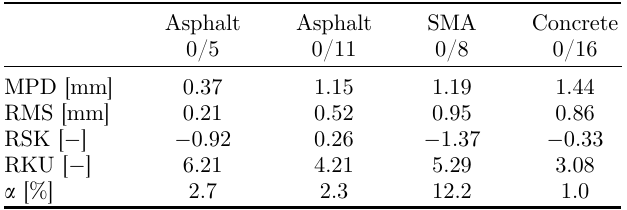
Table 1. Values of the operating conditions chosen for the experimental design.